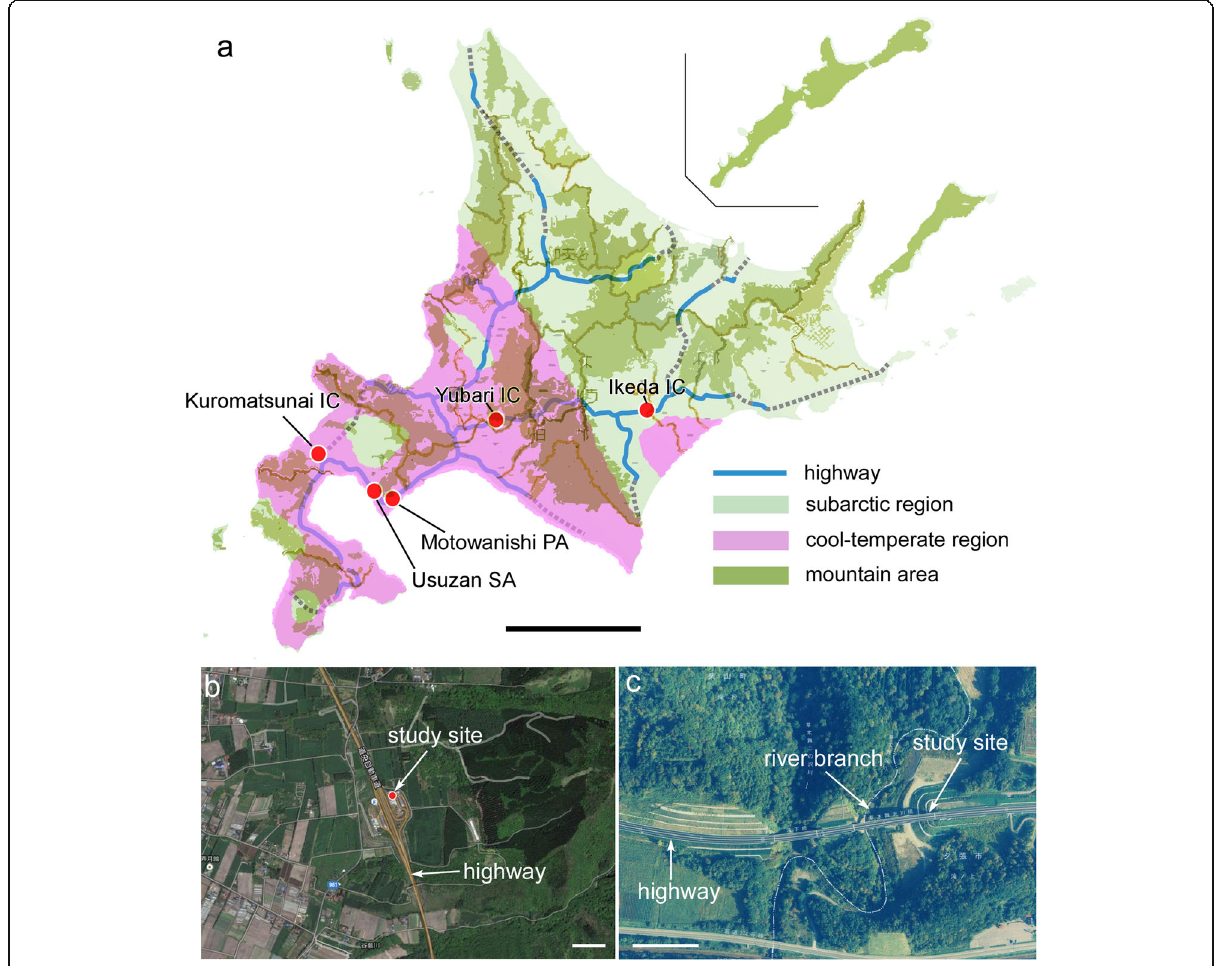
Fig. 1 Study sites. Map of Hokkaido ( a ) showing the moth-abundant sites along the expressways managed by E-NEXCO (blue) overlaid on cool- temperate region (magenta) and subarctic region (green) layers. Mountain areas are shown in dark green. Field experiments in 2014 and 2015 were conducted in the back area of the Mt. Usu (Usuzan) rest area ( a , b ) and those in 2017 and 2018 were conducted on a hill on flat ground beneath an elevated expressway close to the Yubari Interchange ( a , c ). Both study sites had few commercial lights and were surrounded by forests ( b , c ). Scale bars = 100 km in a; 200 m in b and